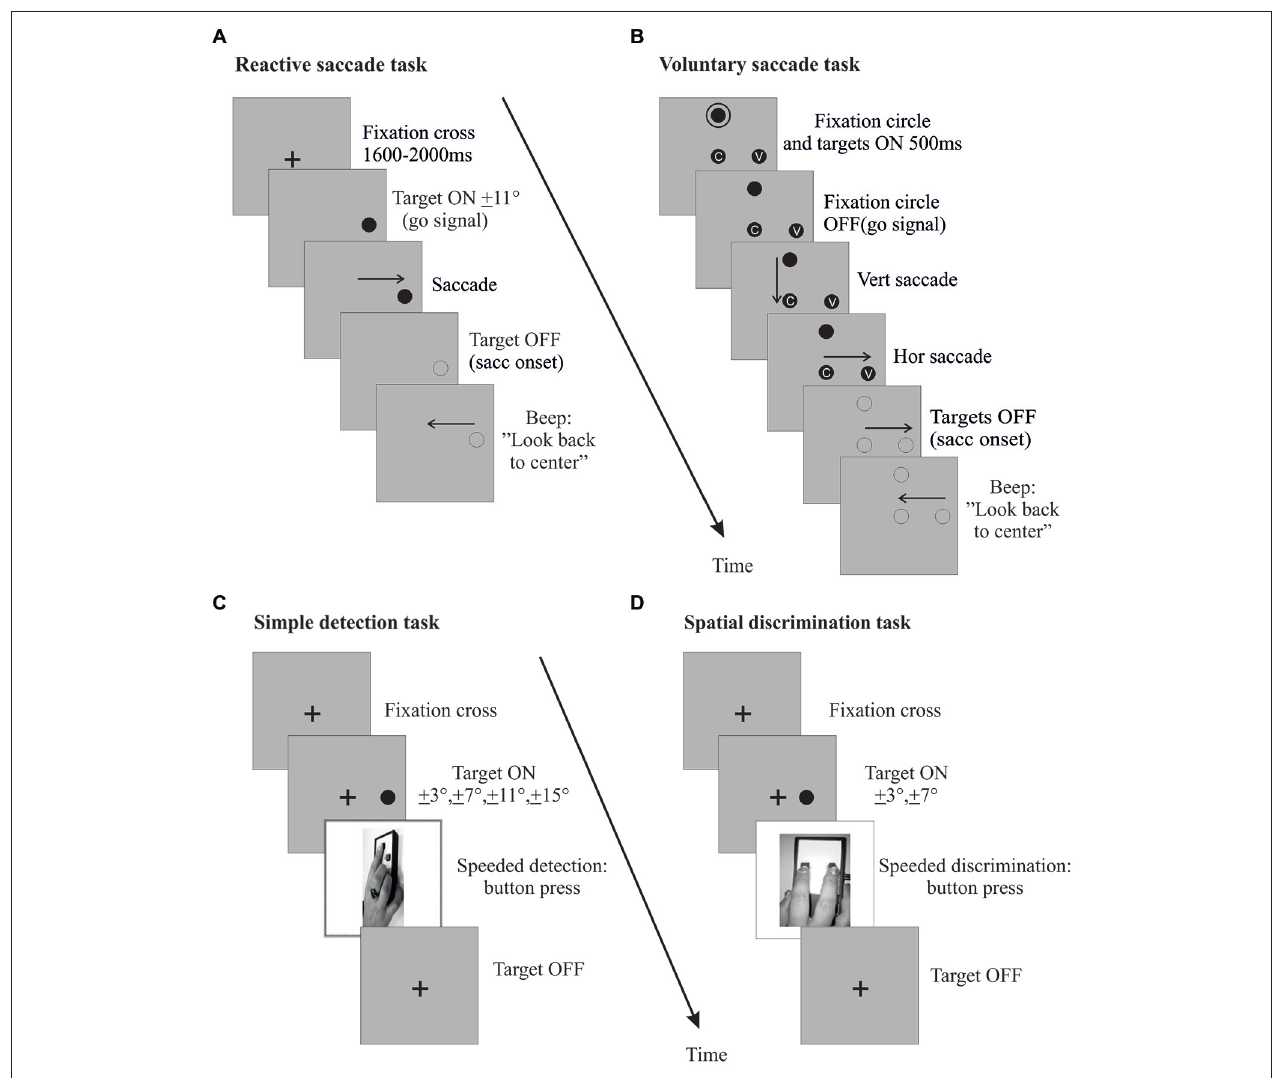
eyes on a central fixation cross throughout the trial. The target was presented at a random position along the horizontal meridian, in the left or right hemi-field (3 ◦ , 7 ◦ , 11 ◦ or 15 ◦ ). The target disappeared when subjects pressed the response button. In the spatial discrimination task (D) , subjects also provided a right hand response as soon as they detected a peripheral visual target while maintaining central fixation, but were further instructed to select the left key or the right key when the target was presented in the left or right hemi-field (3 ◦ or 7 ◦ ), respectively. The target disappeared when subjects pressed the response